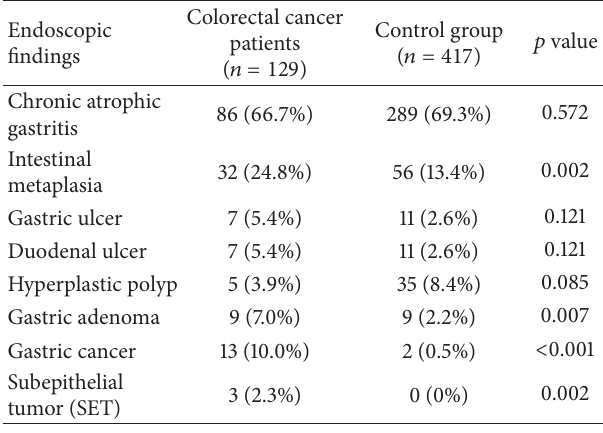
Table 3: Comparison of baseline characteristics and endoscopic findings in the subjects with colorectal cancer patients and control group.